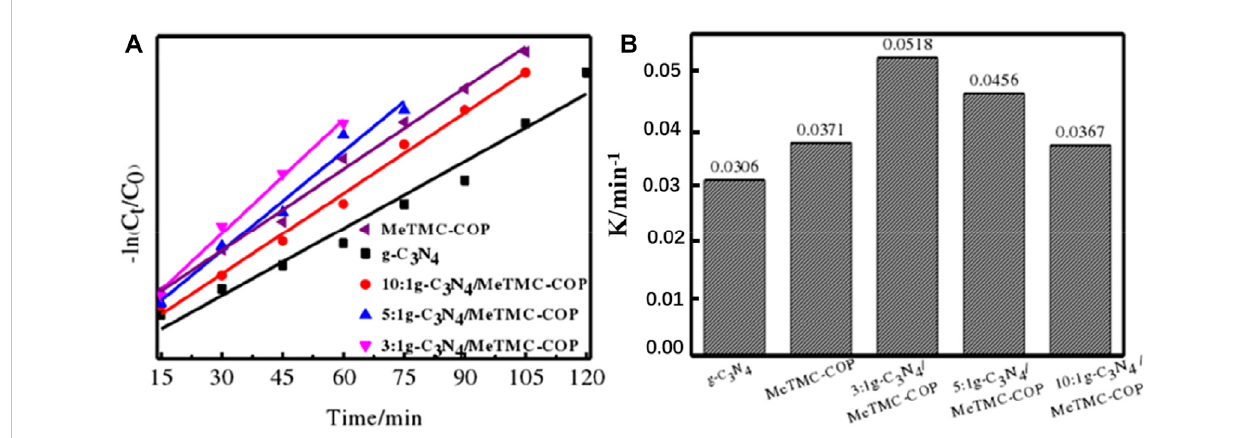
FIGURE 10 Photocatalytic kinetic curves (A) and reaction rate constants (B) of g-C 3 N 4 /MeTMC-COP with different proportions.